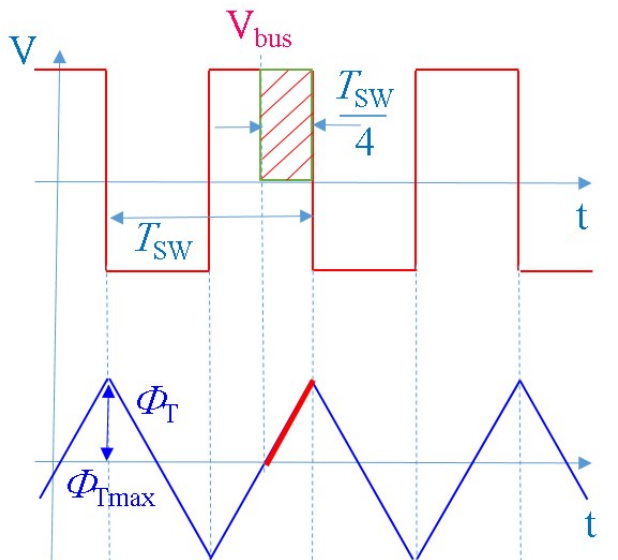
Figure 12. Qualitative voltage and flux density stress on the transformer. ϕ T is the linkage flux and ϕ Tmax is its maximum value.